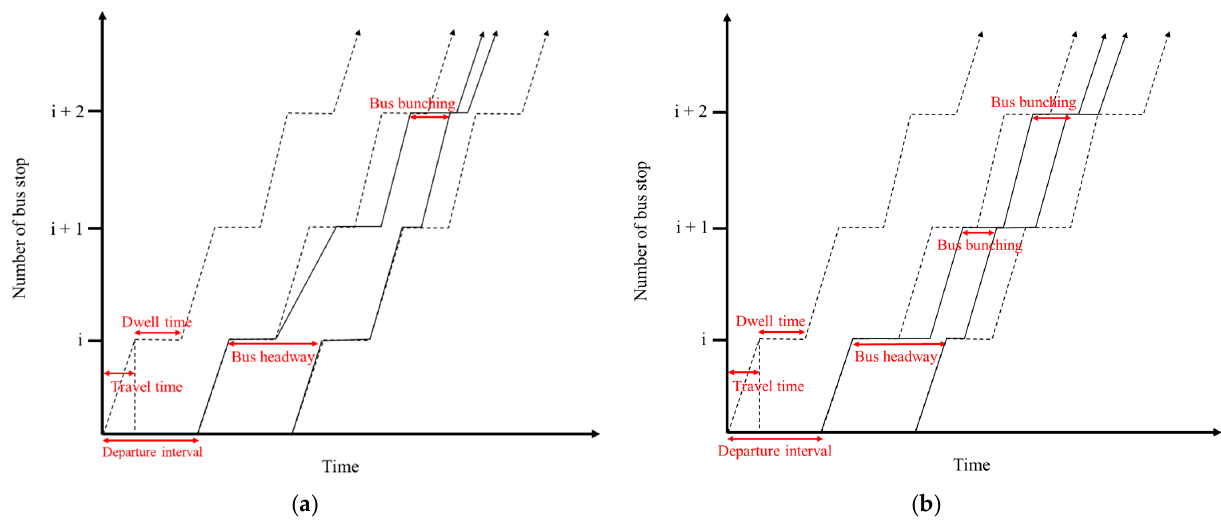
Figure 1. The process of bus bunching in two situations: ( a ) Bus bunching occurs when traveling between bus stops; ( b ) Bus bunching occurs when dwelling at a stop.